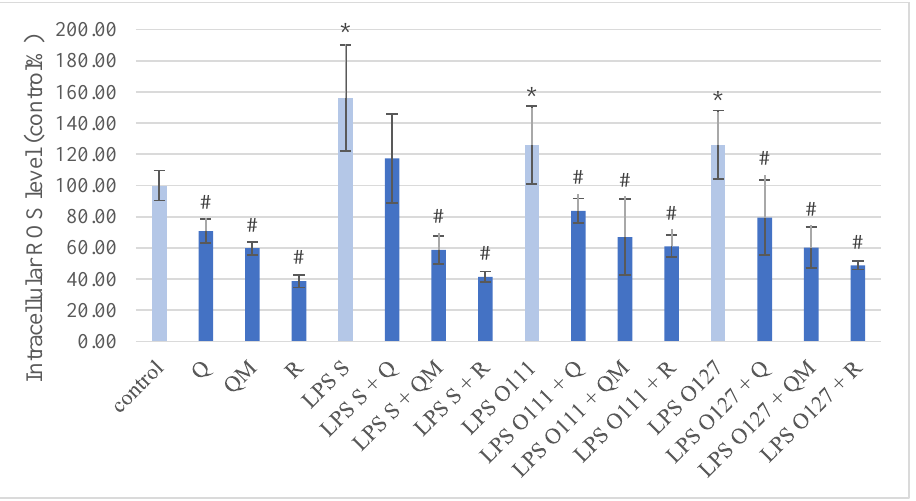
Figure 3. Intracellular reactive oxygen species level in porcine intestinal epithelial cells (IPEC-J2) after treatment with different types of lipopolysaccharides (LPS) from Salmonella Typhimurium (LPS S), E. coli O111:B4 (LPS O111), and E. coli O127:B8 (LPS O127) in 10 µg/mL concentration; quer- cetin (Q), 3-o-methylquercetin (QM) and rhamnazin (R) in 50 µM concentration; and their combina- tions. Data are shown as means with standard deviations ( n = 6/group; * significantly higher p < 0.05; # significantly lower p < 0.05) in control percentage and are statistically compared to those of the control group.